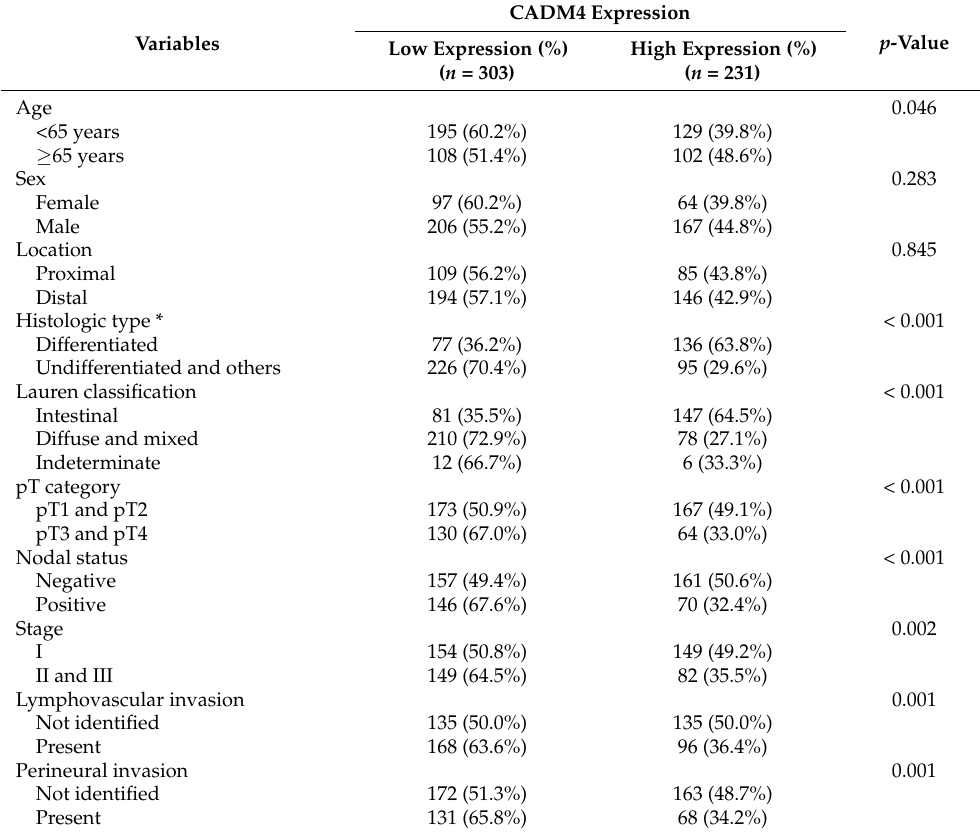
Table 2. Correlations between CADM4 expression and clinicopathological characteristics in patients with gastric adenocarcinoma ( n = 534).